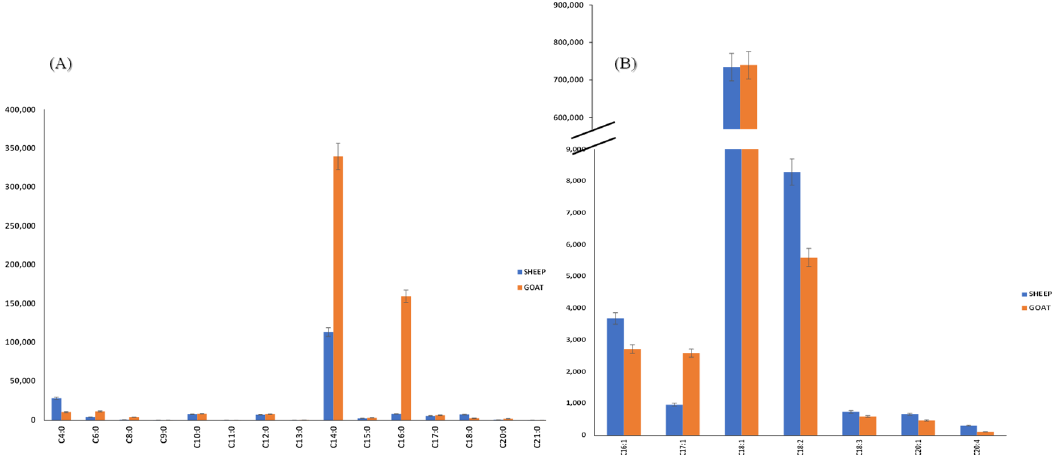
Figure 3. Triacylglycerols’ relative abundance of saturated ( A ) and unsaturated ( B ) fatty acids at the sn ‐ 2 position.